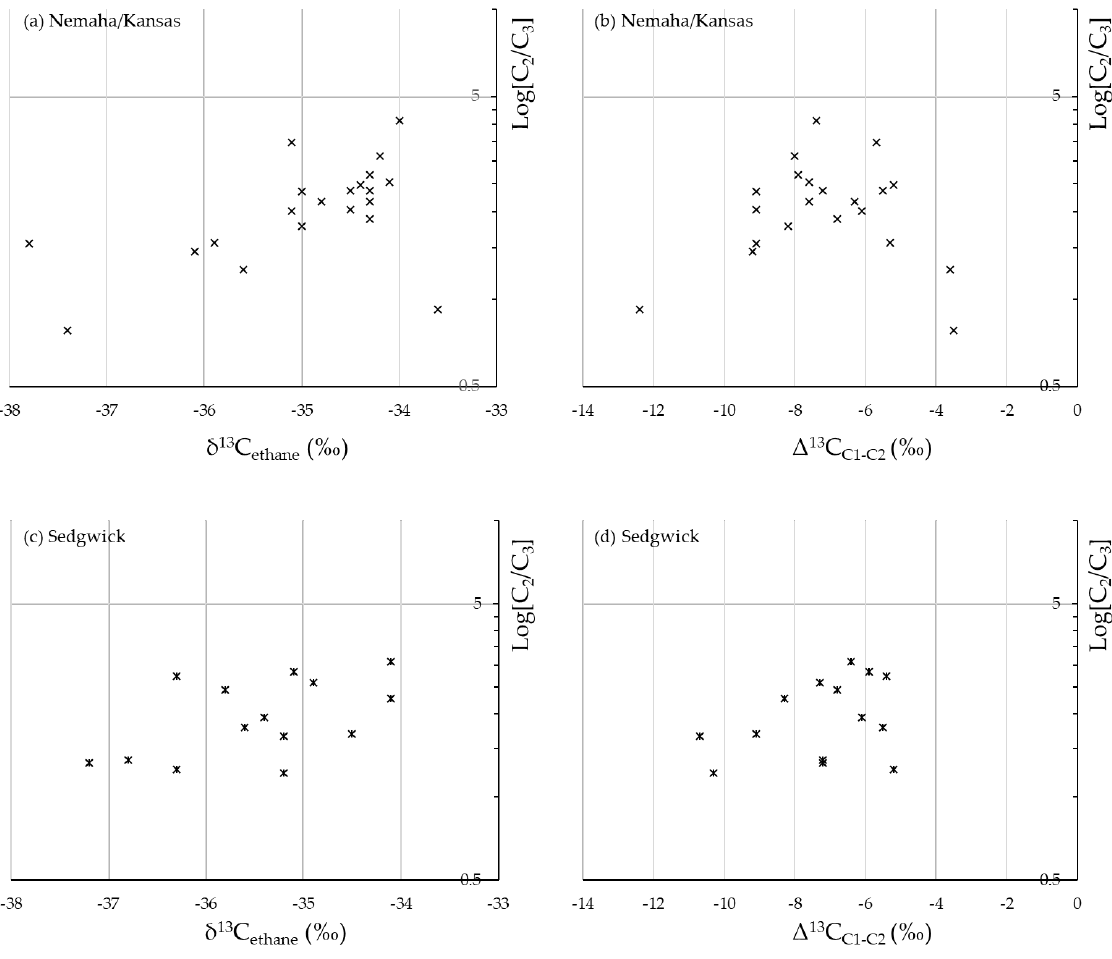
Figure 3. The relationship between the C 2 /C 3 ratio and ( a , c ) the δ 13 C of ethane, and ( b , d ) the ∆ 13 C C1-C2 difference; for samples from the Nemaha/Kansas ( a , b ) and Sedgwick ( c , d ) fields, Kansas